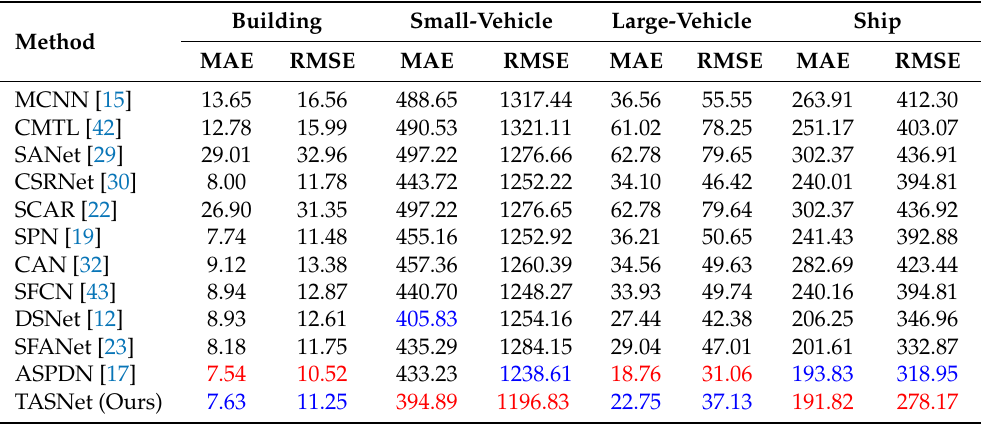
Table 2. Comparative results on the RSOC dataset. The best and the second-best results are high- lighted in red and blue,